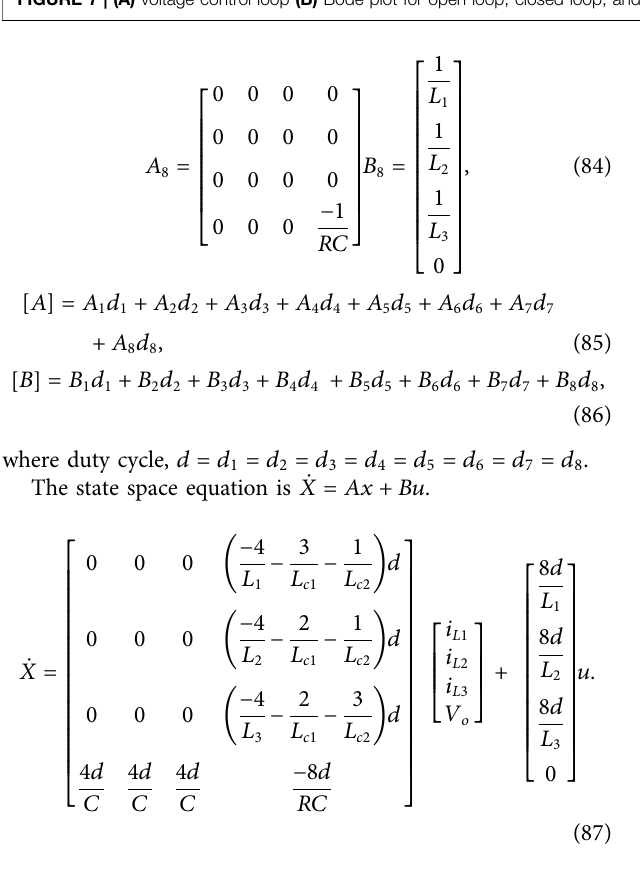
FIGURE 7 | (A) voltage control loop (B) Bode plot for open loop, closed loop, and compensator.